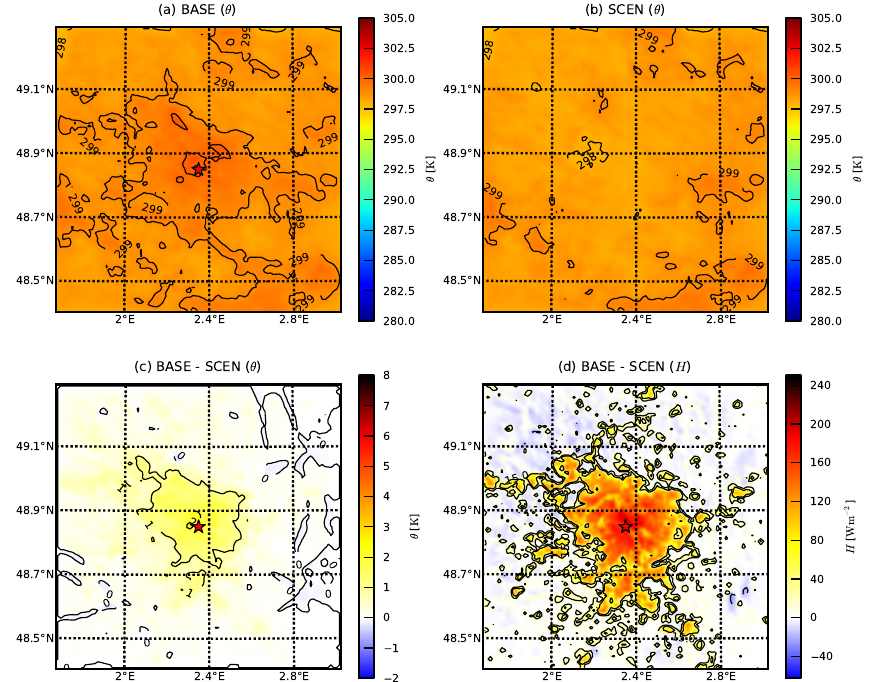
Fig. 8. The same as in Fig. 7, but for 15:00UTC.